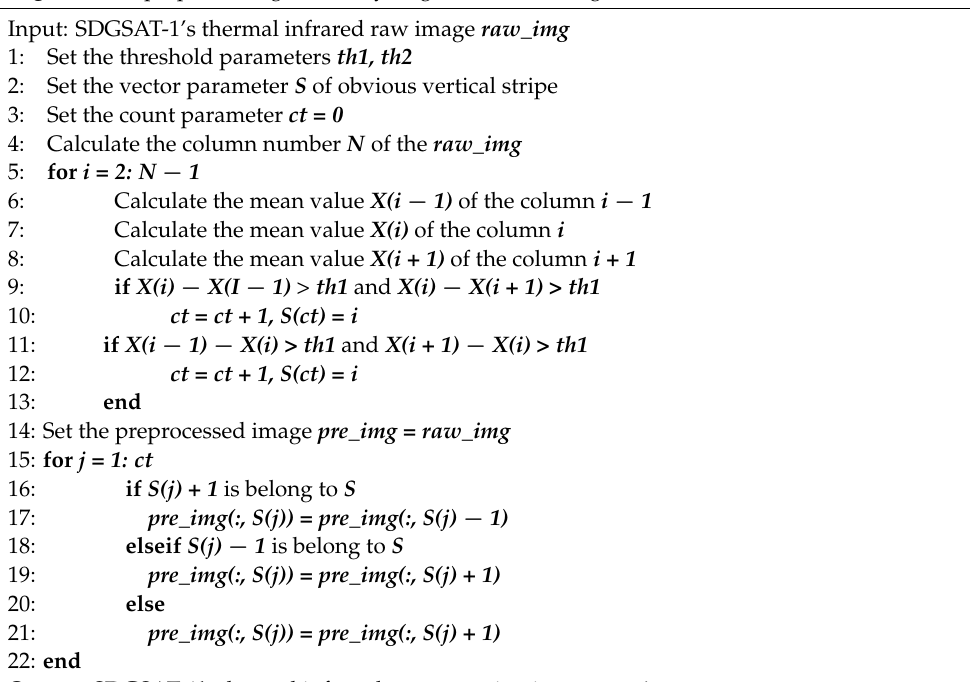
Algorithm 1: preprocessing obviously bright and dark